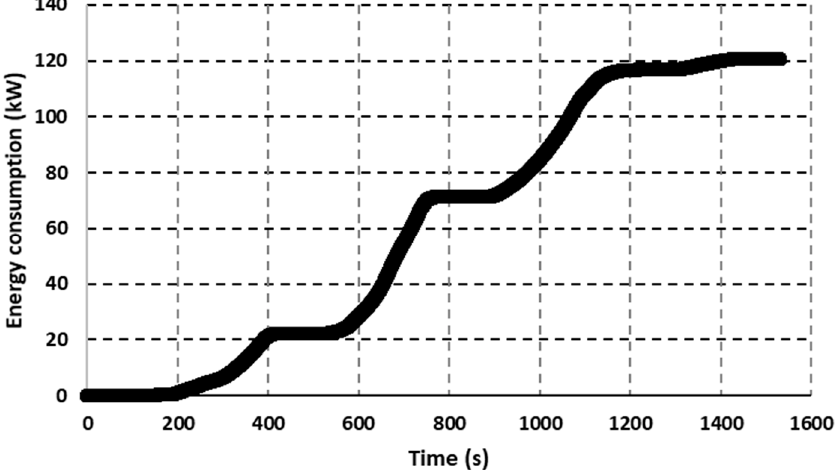
Figure 9. Energy consumption of the train during its path.